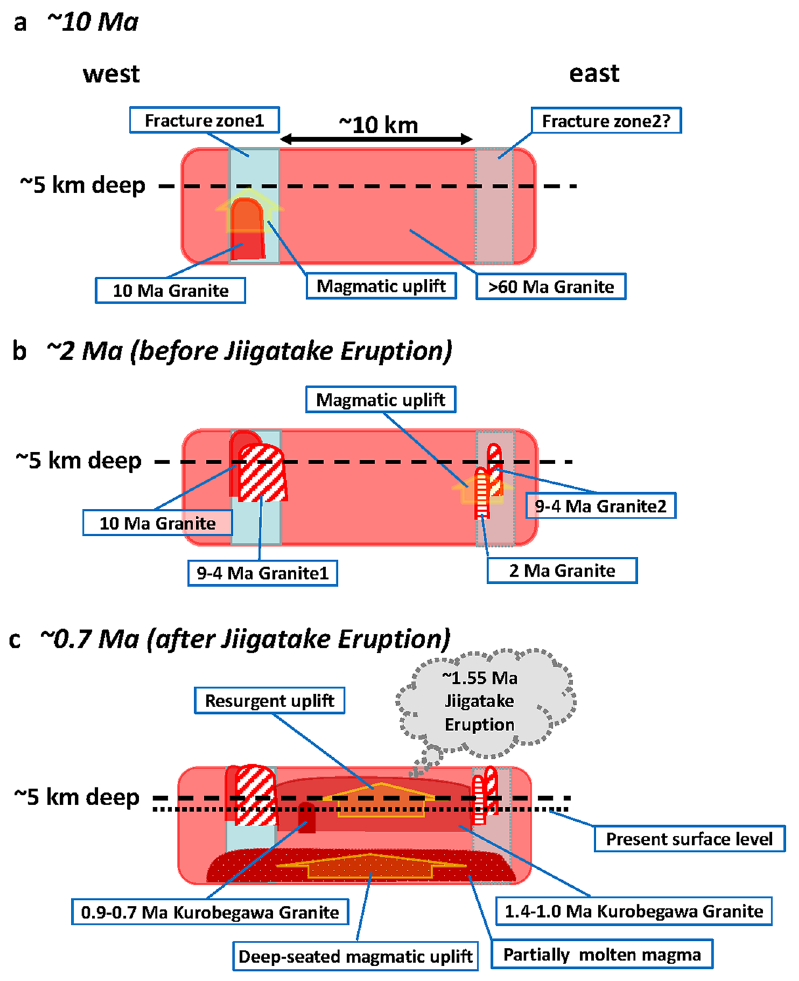
Figure 8. Simplified model of tectonic and magmatic evolution in the Hida Mountain Range at ~ 10 Ma ( a ), ~ 2 Ma ( b ), and ~ 0.7 Ma ( c ). The image was drawn by Hisatoshi